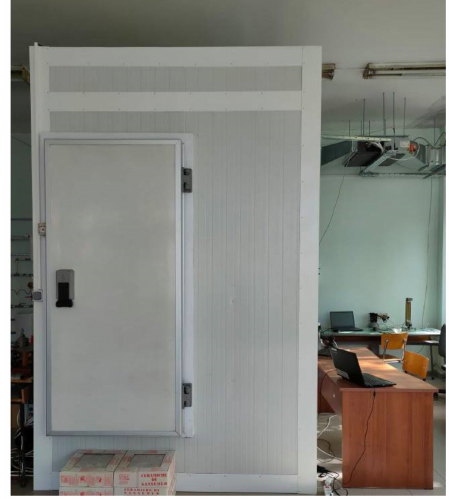
Figure 4. The climate